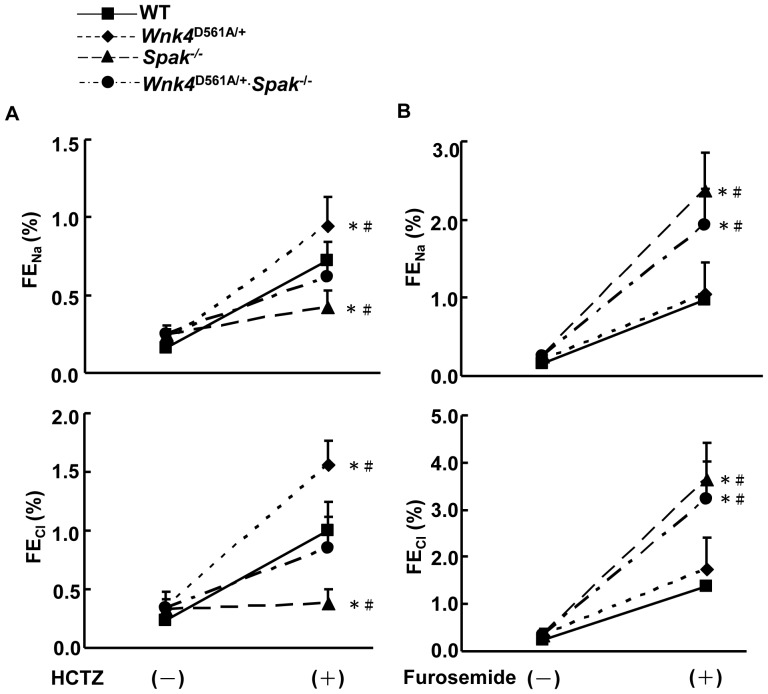

Spak gene deletion normalizes the response to HCTZ and exaggerates the response to furosemide in PHA II mice.Responses of FENa and FECl in WT (▪), Wnk4
D561A/+ (♦), Spak
−/− (▴), and Wnk4
D561A/+.Spak
−/− (•) littermate mice (n = 6/group) to (A) HCTZ and to (B) furosemide. *denotes p<0.05 vs. WT. #
p<0.05 vs. Wnk4
D561A/+.